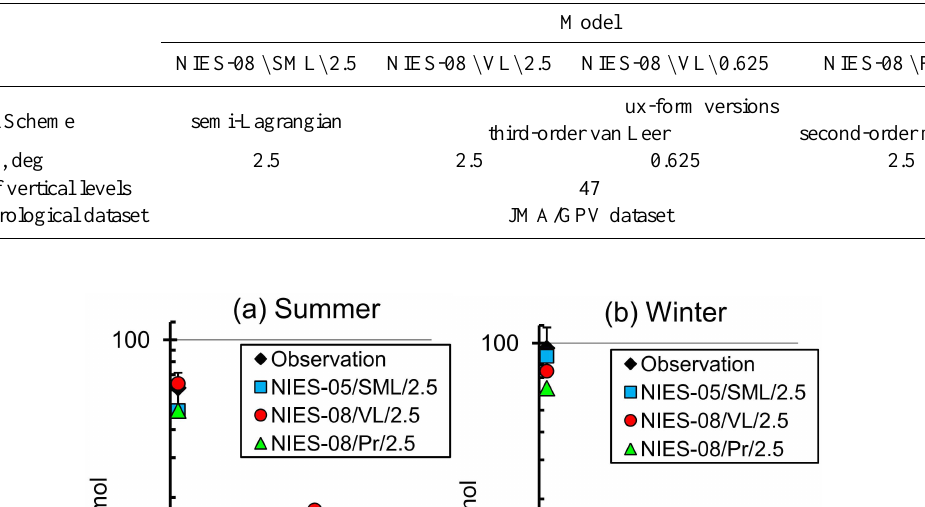
Table 2. Configurations of the NIES TMs.